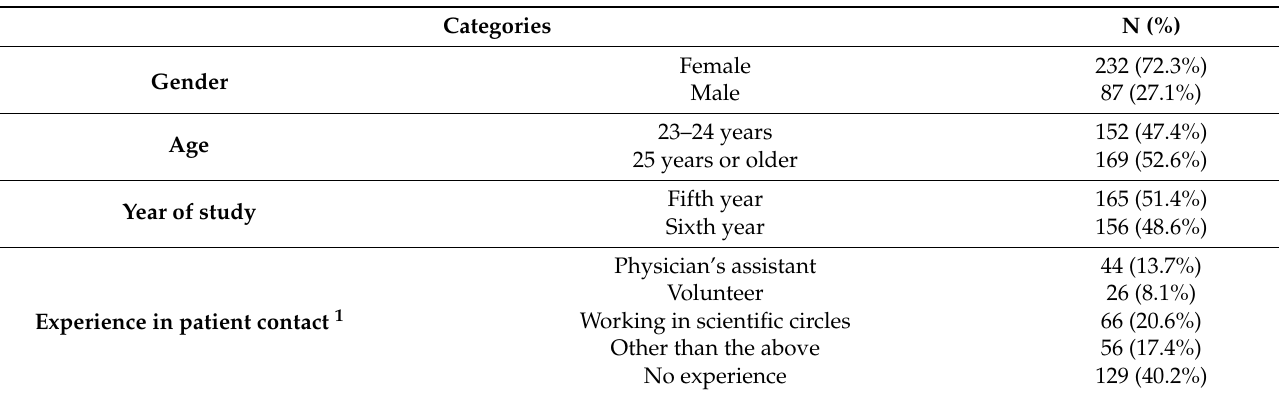
Table 1. Characteristics of